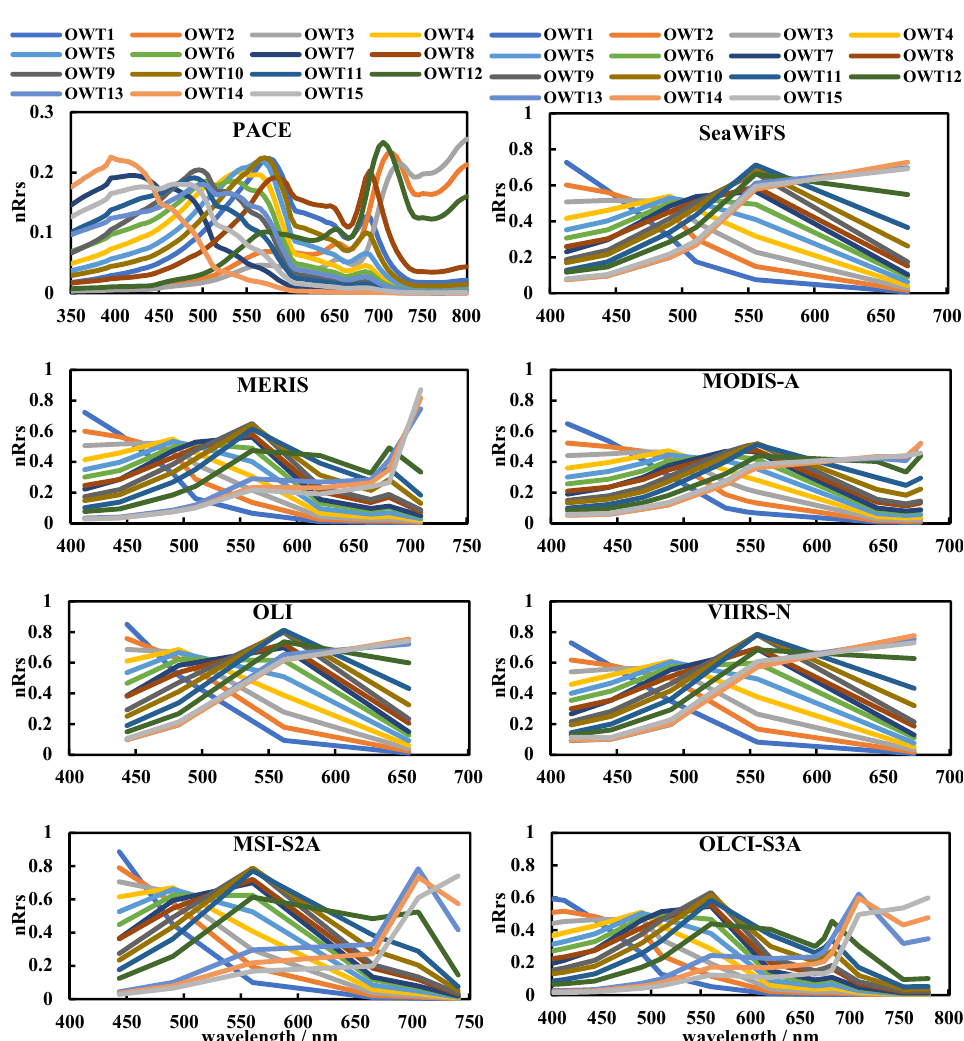
Figure 3. Mean n R rs ( λ ) spectra of U-OWT classes 1–15 corresponding to the hyperspectral (PACE) and different multispectral (SeaWiFS, MERIS, MODIS-A, OLI, VIIRS-N, MSI-S2A, and OLCI-S3A) satellite